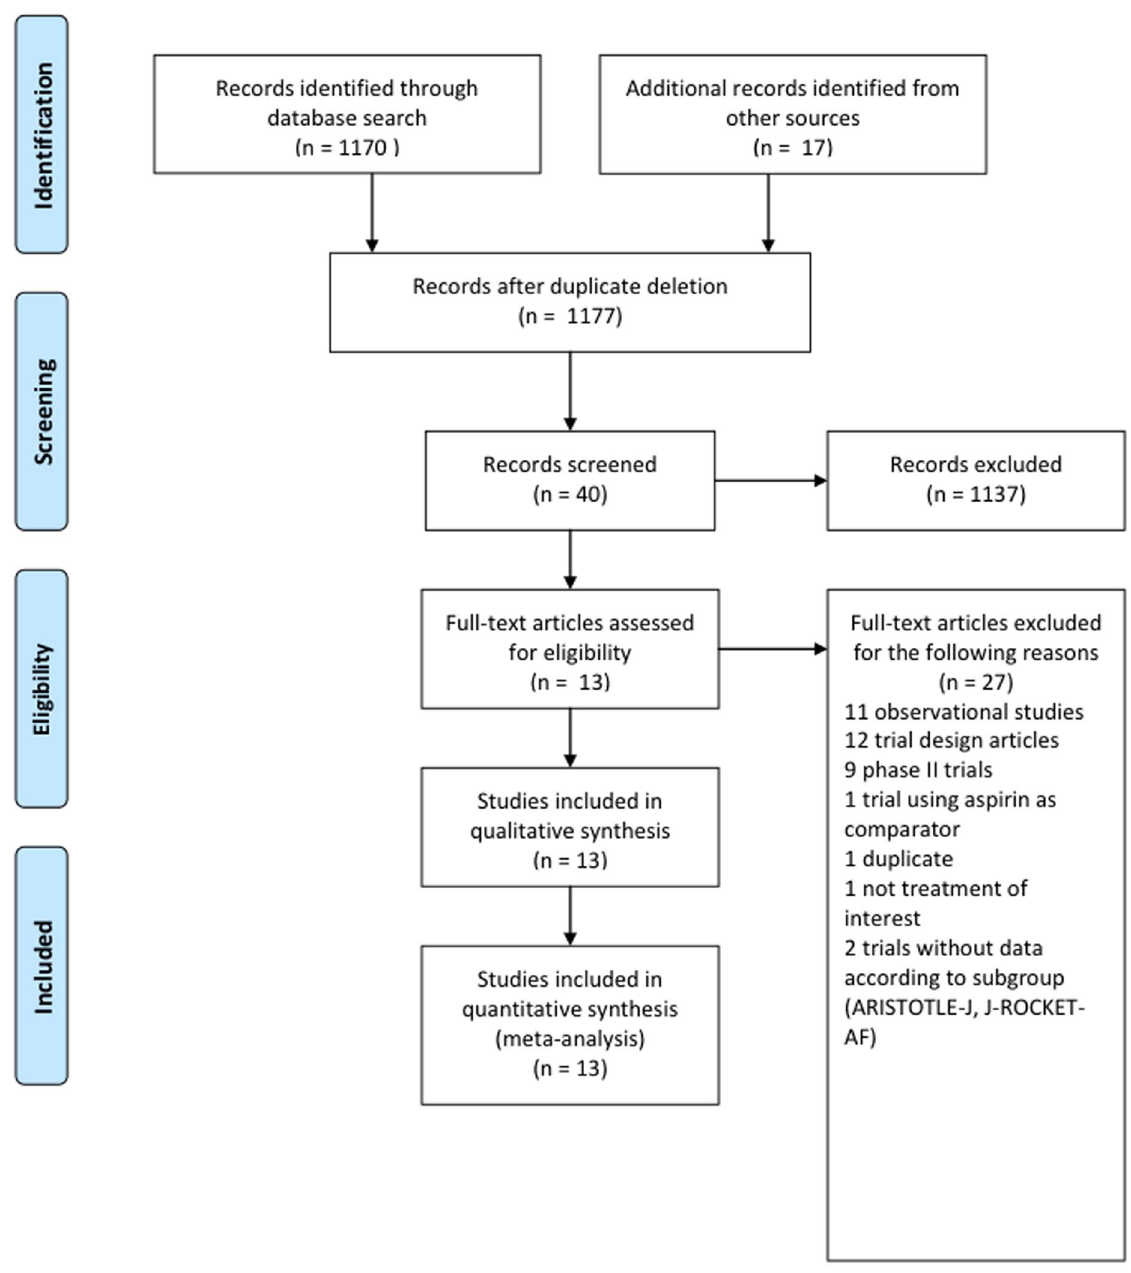
Figure 1. Flow chart for trial selection.